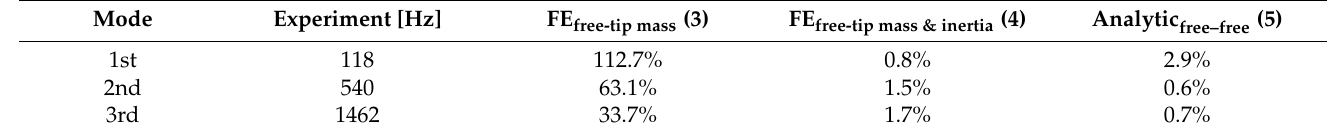
Table 3. Relative deviation of the results determined by the simplified finite element models and the analytical solution to the experimental results of the eigenfrequencies of the first three bending modes. Only the first specimen is taken into